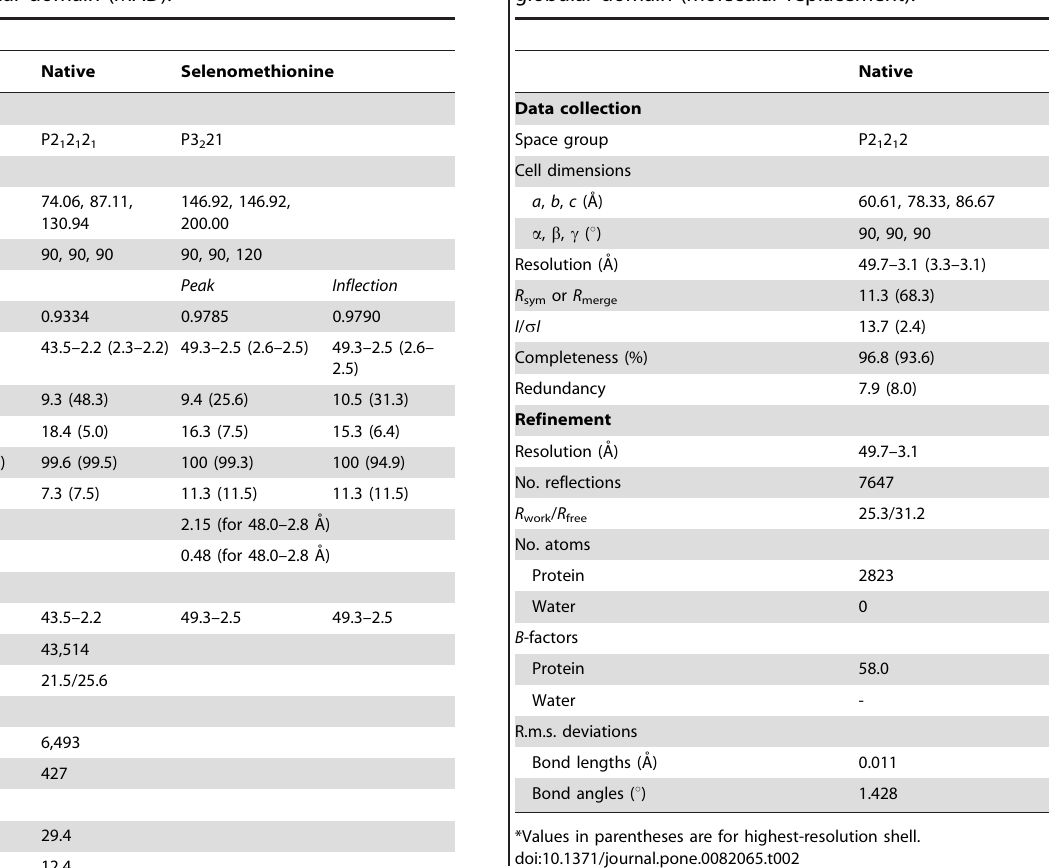
Table 1. Data collection, phasing and refinement statistics for Myo5a globular domain (MAD).